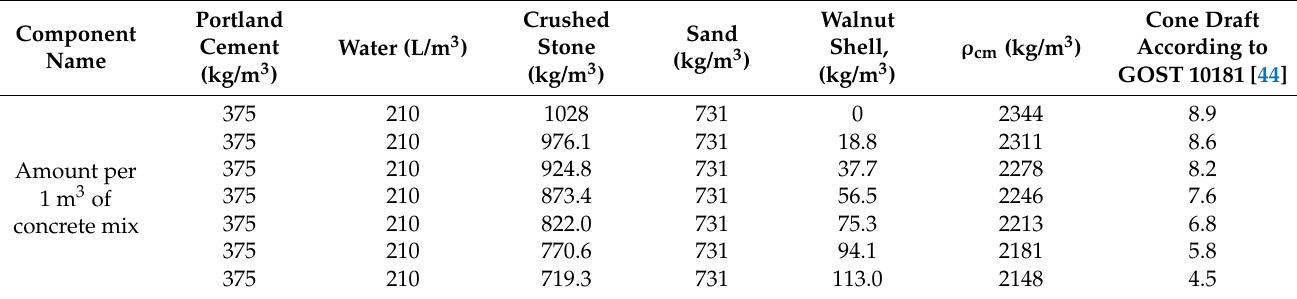
Table 3. The concret-mix